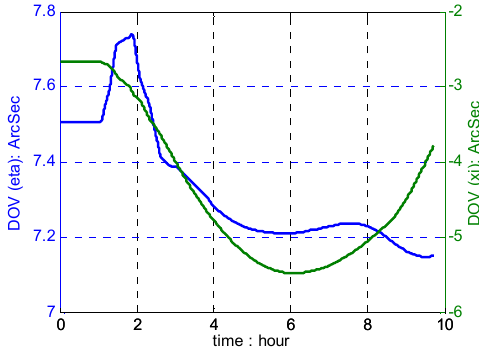
Figure 12. DOVs on the trajectory.